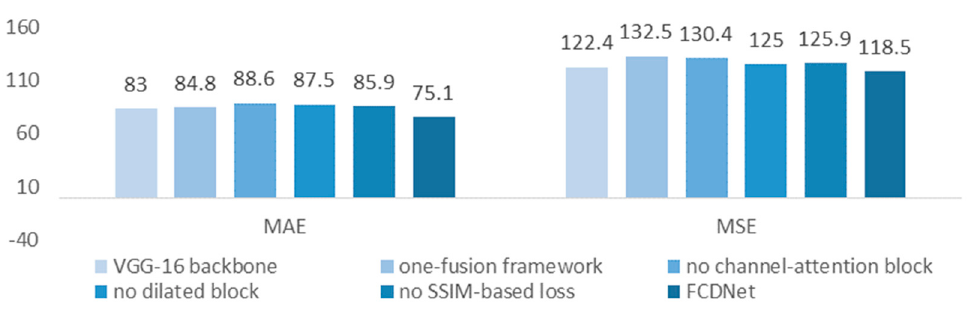
Figure 4. The estimation errors of the ablation study.